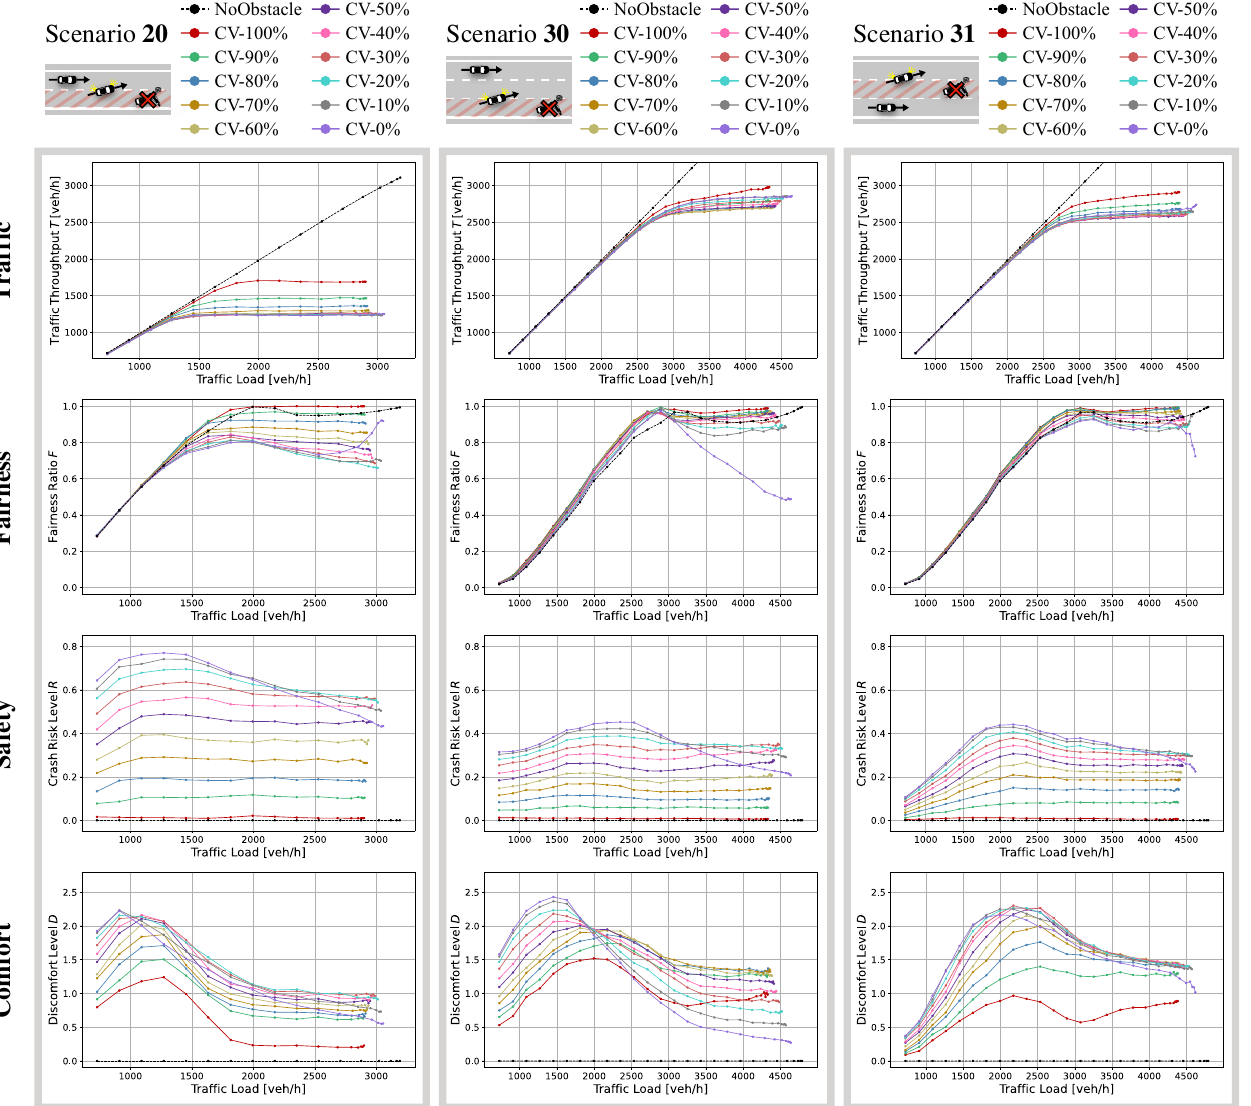
Figure 10. Simulation results showing impact of CV penetration ratio under different traffic loads, d avoid = 300m, d prelim = 100m, d decel =